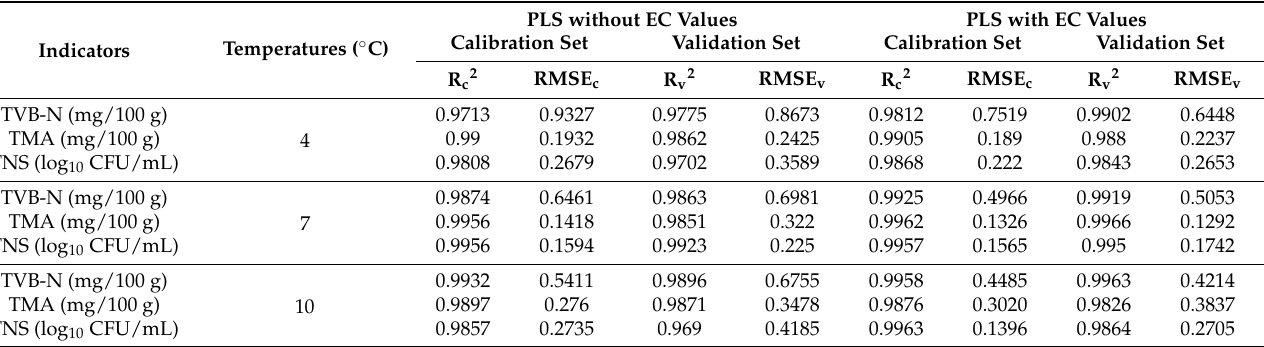
Table 3. Calibration and validation results in tuna stored at different temperatures based on the PLS model with and without EC